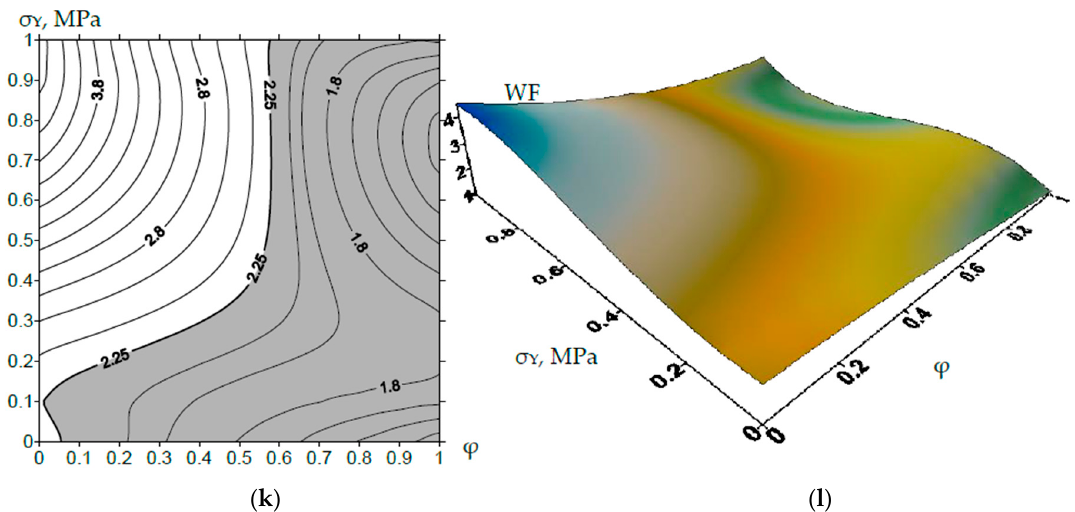
Figure 16. Isoline patterns on the operational properties of the UHMWPE-based composites: elastic modulus E, MPa ( a , b ); ultimate tensile strength σ U , MPa ( c , d ); elongation at break ε , % ( e , f ); impact toughness a k , kJ/m ( g , h ); the friction coefficient f ( i , g ); and wear rate I, 10 − 6 mm 3 ∙ N − 1 ⋅ m − 1 (Load = 140 N, Velocity = 0.5 m ∙ s − 1 ) ( k , l ).